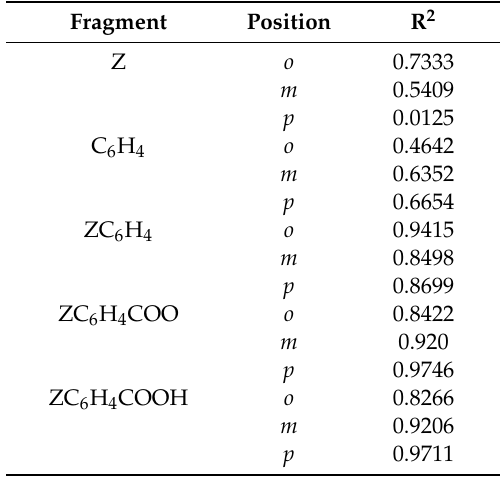
Table 3. Two parameter correlation analysis ∆ acid G ◦ (kcal / mol) = b + m χ fragment (eV) for 1a – 6c